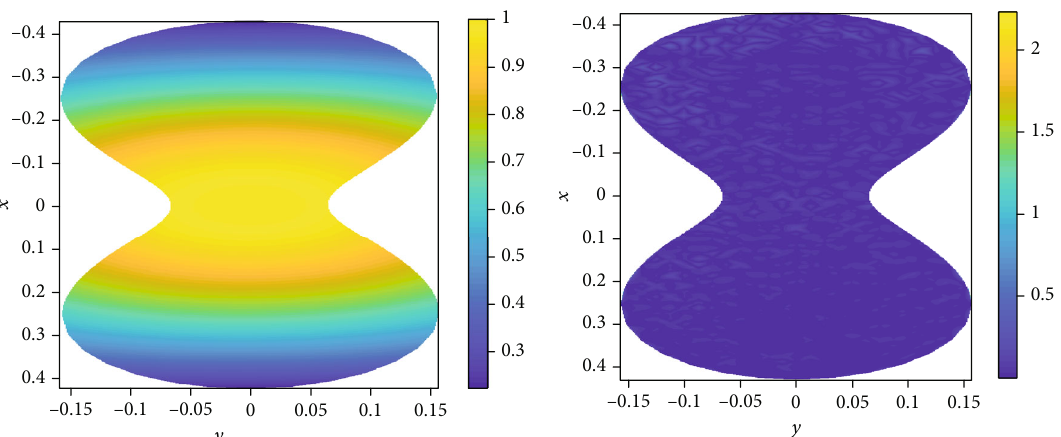
Figure 3: Approximate solution and its absolute error on irregular domains.